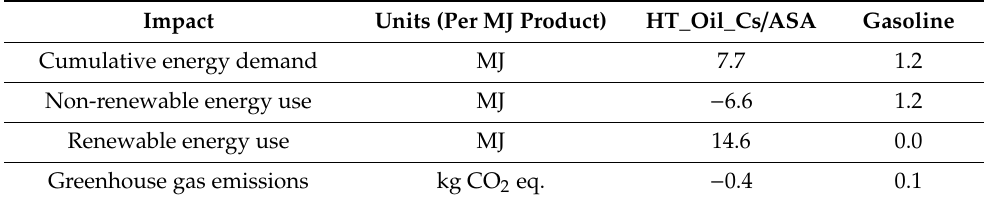
Table 4. CED and GHG emissions associated with pyrolysis-based fuel and gasoline. Non-renewable energy use and renewable energy use together constitute the cumulative energy